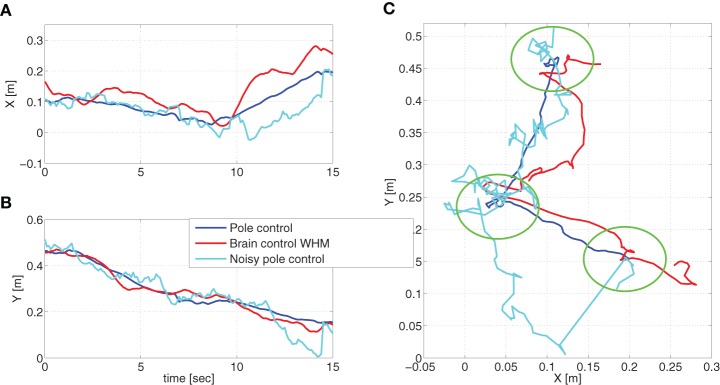
Movement trajectories. Representative traces of the cursor during simulated pole control, brain control and noisy pole control (with αrec = 0.035). To facilitate comparison, the same set of targets (marked by green circles) and desired reaching times was used in these three simulations.